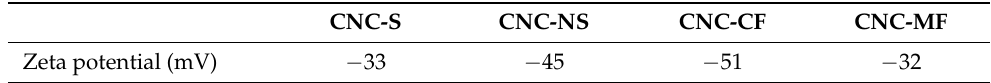
Table 2. Zeta potential of CNC suspensions.